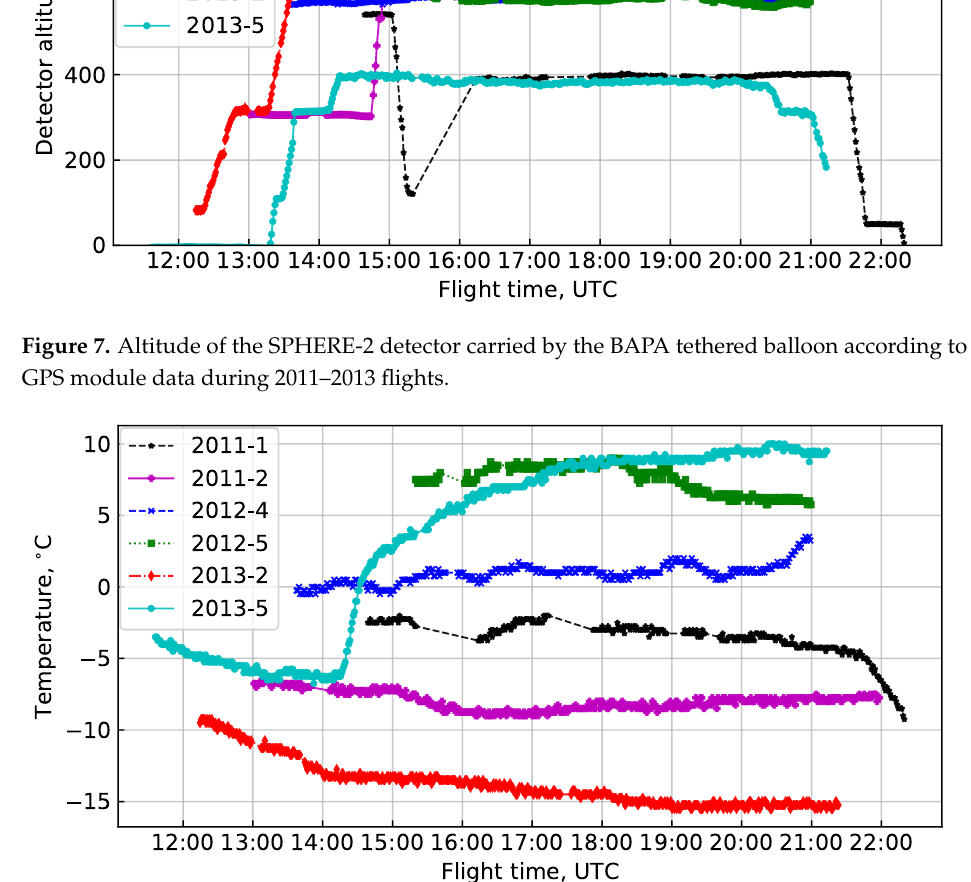
Figure 8. Air temperature near the PMT mosaic during 2011–2013